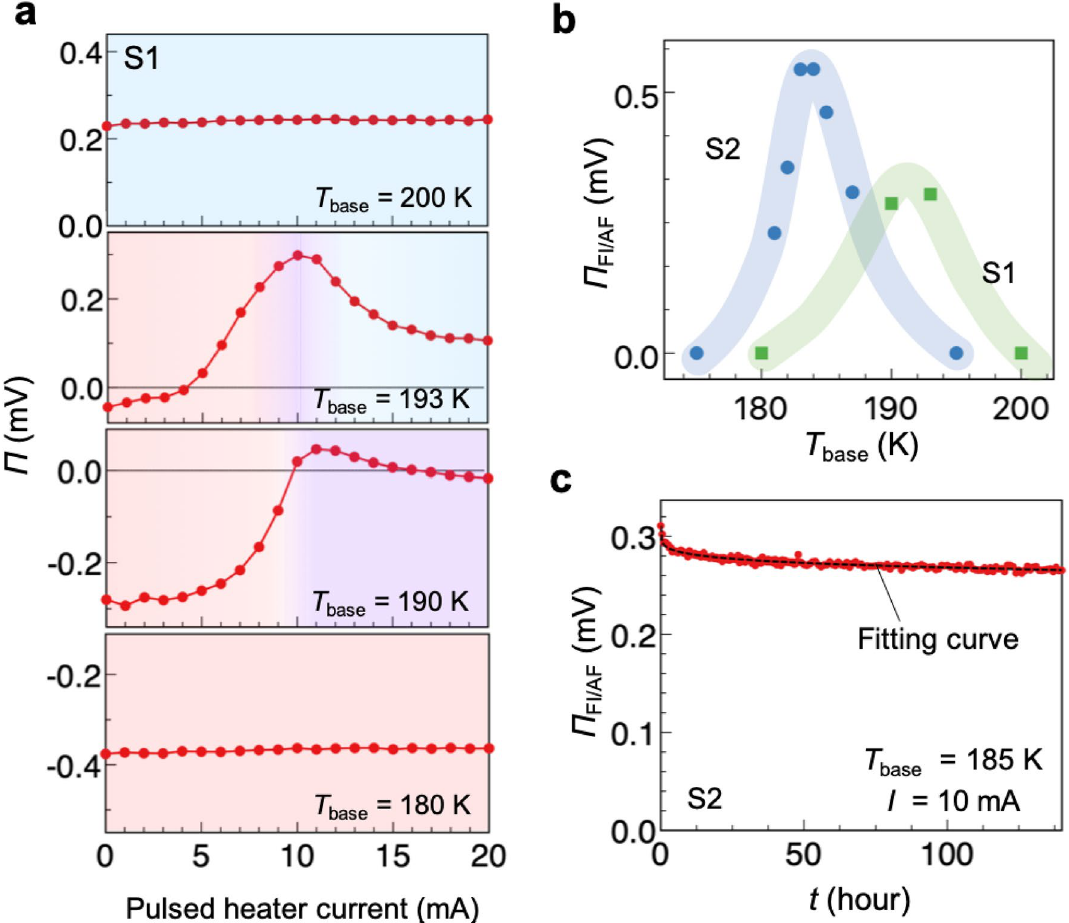
Figure 4. Base-temperature and time dependences of the single-material Peltier effect. ( a ) Pulsed heater current dependence of the Peltier coefficient of S1 measured at T base = 200, 193, 190, and 180 K. The red, purple, and blue regions correspond to the different sample situations illustrated in Fig. 2c and d. The standard deviations constitute error bars, which are small and invisible in the figure. ( b ) Base temperature dependence of Π FI/AF for S1 and S2. The blue and green curves are guides for the eyes. Error bars are small and invisible in the figure. ( c ) Time dependence of Π FI/AF measured for S2. T base is set at 185 K, and the pulsed heater current is 10 mA. The dotted line is the fitting curve (see